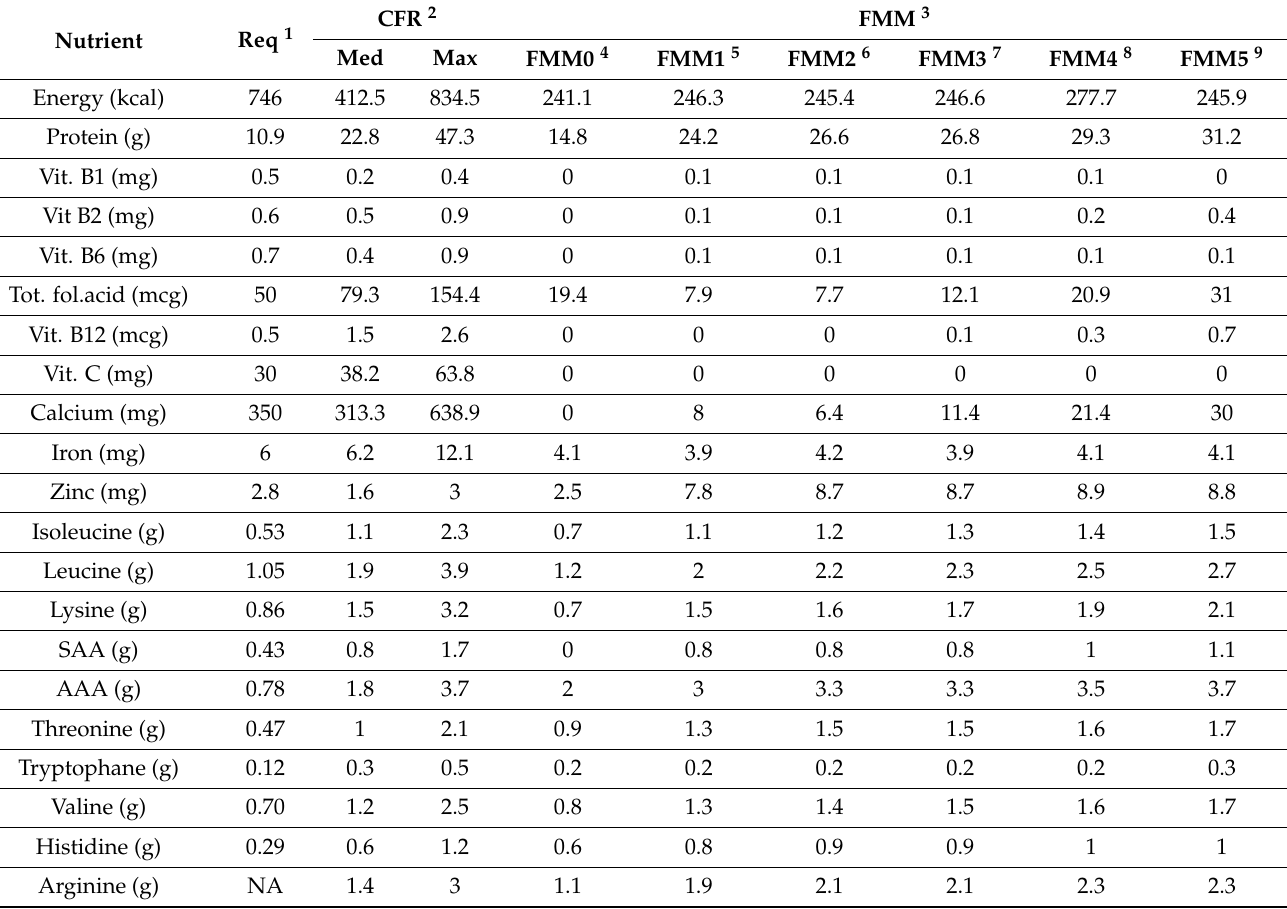
Table 5. The Fulfillment of Nutrient Requirements by CFR and